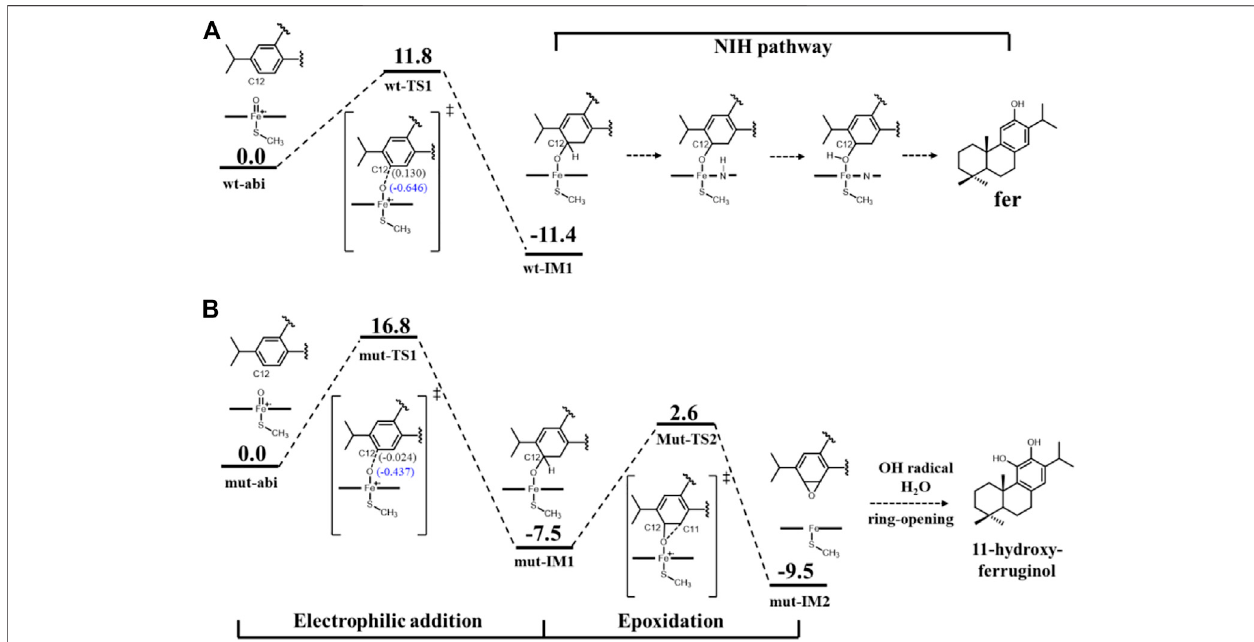
FIGURE 8 | Reaction diagram [B3LYP-D3/def2TZVP//B3LYP-D3/def2SV(P)] for (A) wt-abi complex and (B) mut-abi complex. The values in brackets represent Mullikan charge. The cluster models are prepared from MD simulations of systems wt-abi-Cpd I and mut-abi-Cpd I as shown in Supplementary Figure S4 . The distanceofFe-C12andFe-O-C12anglesisreasonable,sincethedistanceislessthan4 Å,andtheangleis fl uctuatingbetween110 ° and130 ° ( SupplementaryFigure S7 ). The corresponding optimized structures are given in Figure 9 .